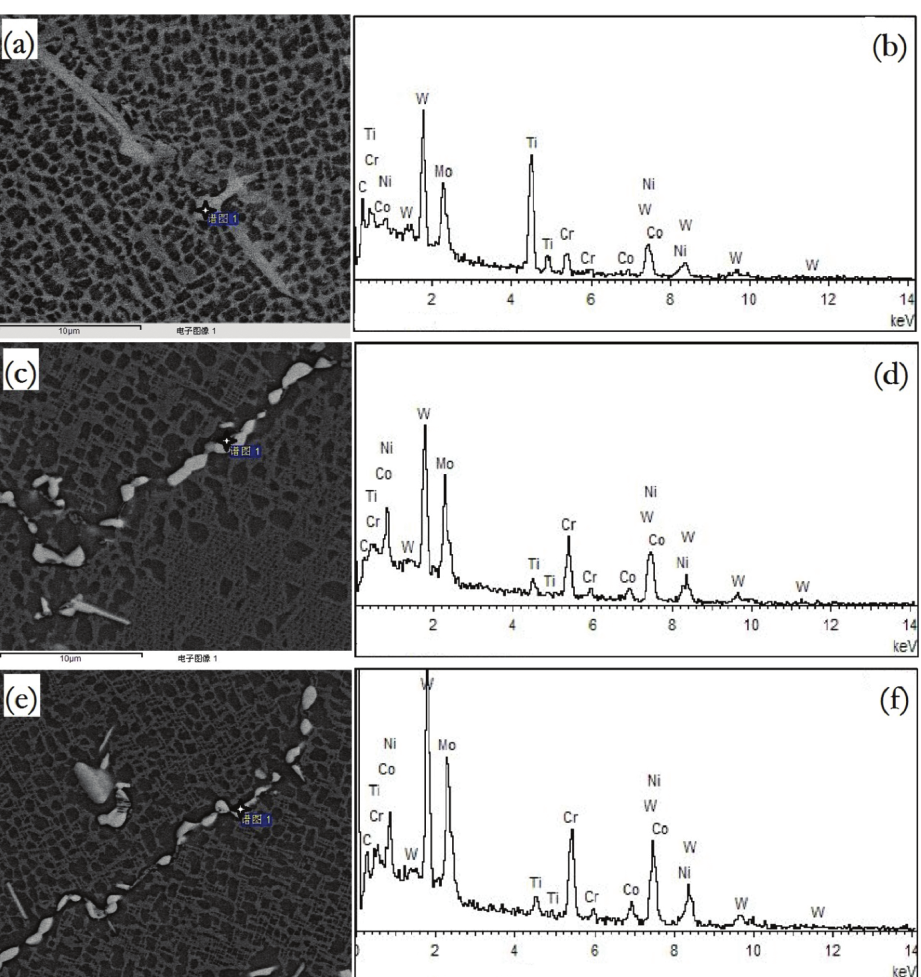
Figure 4: EDS spectrum of carbides at grain boundaries in non-HIPed and HIPed specimens: (a), (b) Cas; (c), (d) H35; (e), (f) H45.